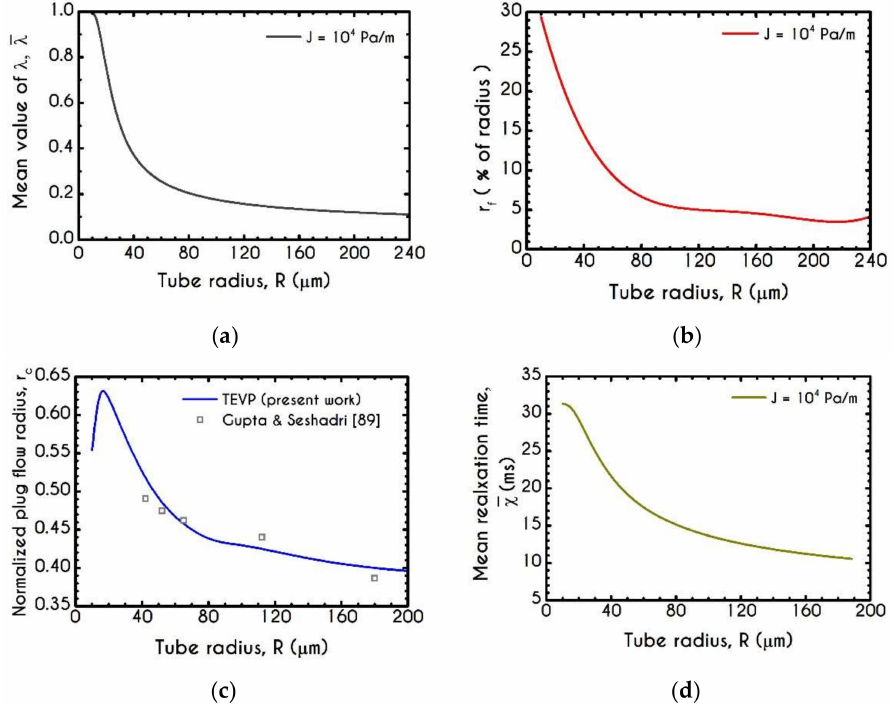
Figure 11. ( a ) Mean structure parameter λ , ( b ) Fully structured region r f as a percentage of the radius of the tube R, ( c ) Normalized plug velocity size r c along with the experimental data of Gupta and Seshadri [89] for the same quantity and ( d ) Mean relaxation time χ as a function of the microtube radius. In all cases J = 10 4 Pa/m and H c =